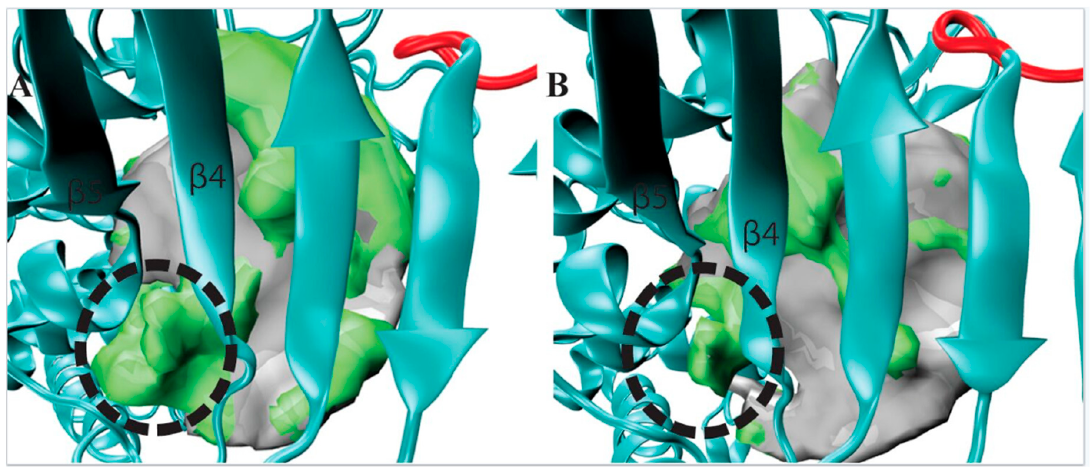
Figure 4. A side pocket was identified from visualizing our POVME results for the centroid of Cluster 1 (TbRET1, Panel A ). The same region is compared with the centroid of Cluster 2 (TbRET2 Panel B ) to demonstrate the pronounced pocket volume increase. Additional regions opening only in that cluster are shown as a green surface relative to the average pocket volume. The side pocket is located between β 4 and β 5.